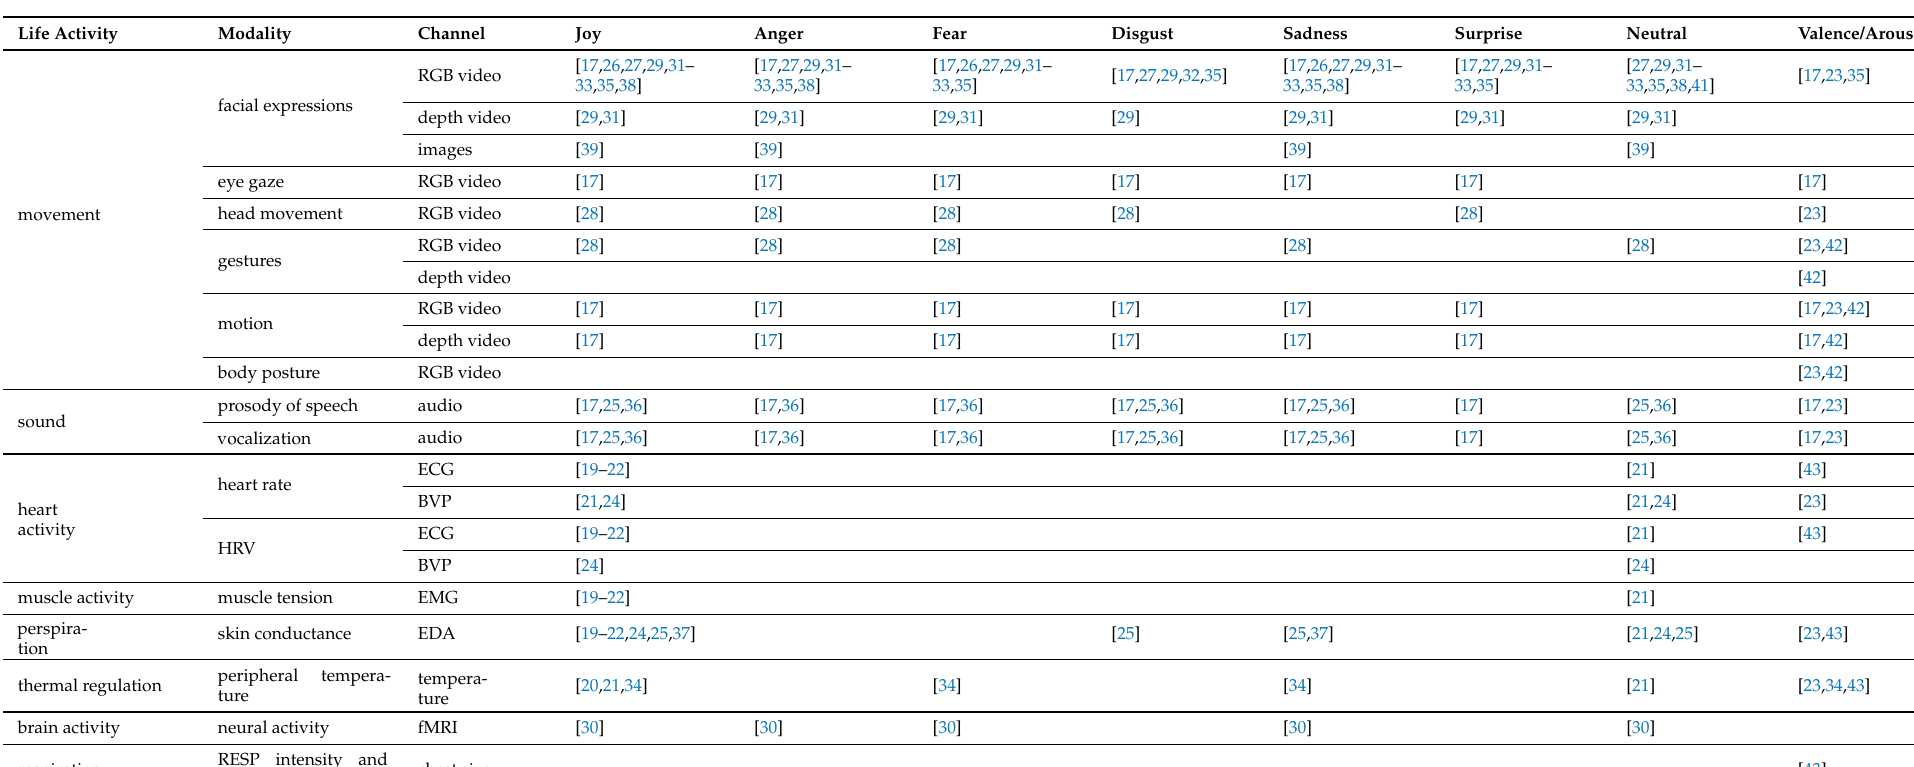
Table 6. Emotions recognized in the Ekman and Russel models, enriched with neutral emotion corresponding to channels used in the process of emotion